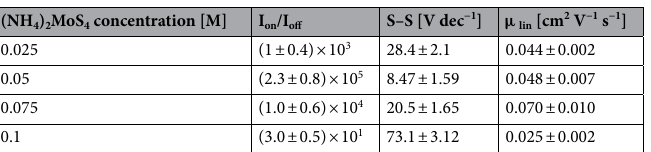
(NH 4 ) 2 MoS 4 concentration